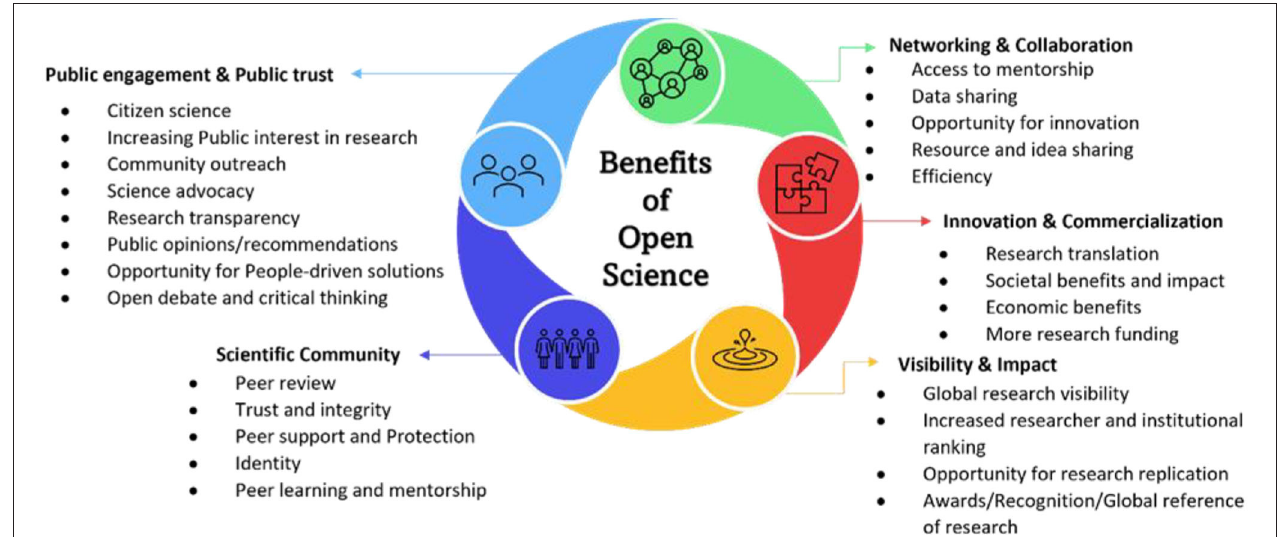
FIGURE 2 | Benefits of open